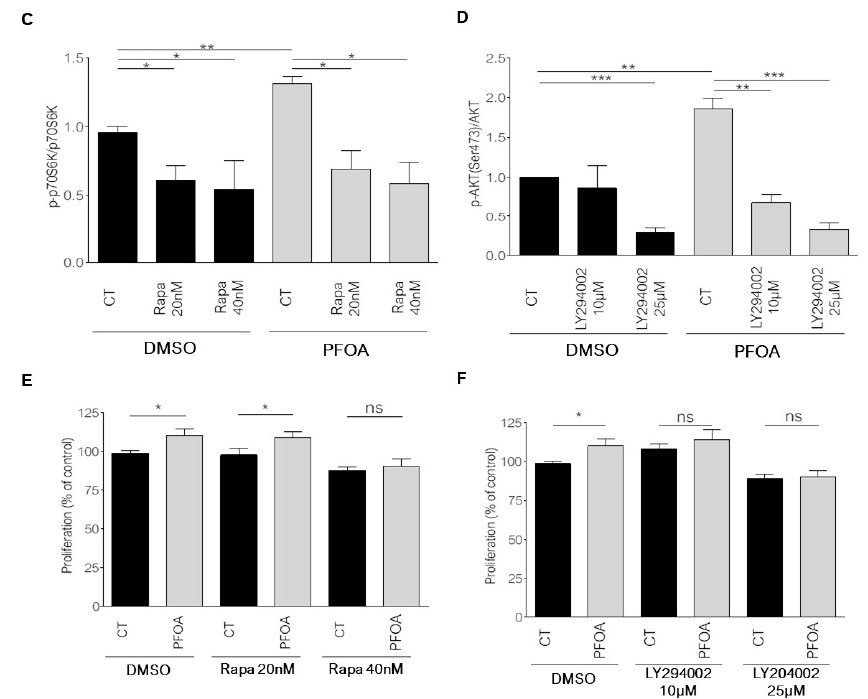
Figure 5. PFOA increases proliferation via Akt and mTORC1 in MCF7 cells. ( A ) Western blot of phospho-p70S6Kinase (Thr389), total p70S6Kinase and Actin of MCF7 cell protein extract after 48 h of treatment with PFOA (10 − 12 M) in comparison with cells treated with EtOH (CT) and overnight exposure with either DMSO or Rapamycin (20 nM or 40 nM). ( B ) Quantification of protein level of three different western blot experiments. ( C ) BrdU cell proliferation assay. Measured proliferation of MCF7 cells after 48 h treatment with PFOA (10 − 12 M) in comparison with cells treated with EtOH (CT) and overnight exposure with either DMSO or Rapamycin (20 nM or 40 nM). Each bar represents a mean ± SEM of 3 independent experiments. ( D ) Western blot of phospho-AKT(Ser473), AKT total and HSP90 of MCF7 protein extract after 48 h of treatment with PFOA (10 − 12 M) in comparison with cells treated with EtOH (CT) and overnight exposure with either DMSO or LY294002 (10 µM or 25 µM) overnight exposure. ( E ) Quantification of protein level of three independent western blot experiments. ( F ) BrdU cell proliferation assay. Measured proliferation of MCF7 cells after 48 h treatment with PFOA (10 − 12 M) in comparison with cells treated with EtOH (CT) and overnight exposure with either DMSO or LY294002 (10 µM or 25 µM). Each bar represents a mean ± SEM of 3 independent experiments. * p < 0.05; ** p < 0.005; *** p < 0.0005; ns: non-significant.